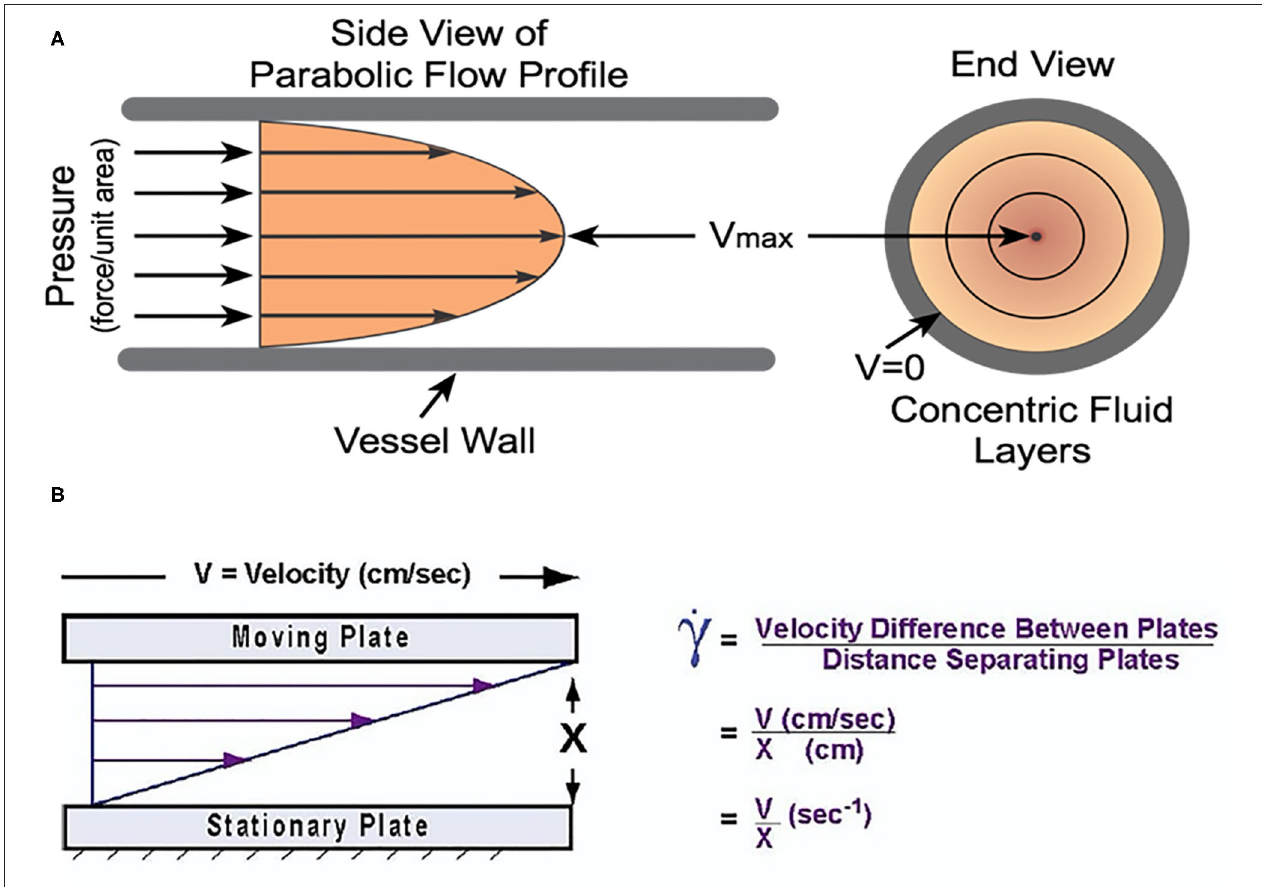
FIGURE 2 | (A) The velocity gradient due to shear forces in blood. The fluid layers have differential velocity according to their position along the radial axis. It is worth noting that the viscosity gradient is the inverse of this gradient with the lowest viscosity at the center of the vessel and the highest nearest the vessel wall. Reprinted with permission from: Cardiovascular Physiology Concepts. cvphysiology.com Richard E. Klabunde, PhD. (B) The velocity gradient in blood is due to the differential forces acting upon each fluid layer due to the distance from the vessel wall. Adapted with permission from Papaioannou and Stefanadis